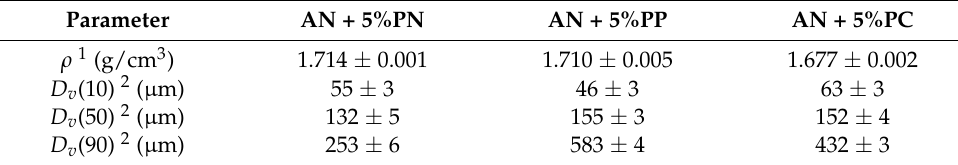
Table 2. Density and particle size of AN and PSAN with various potassium salts.